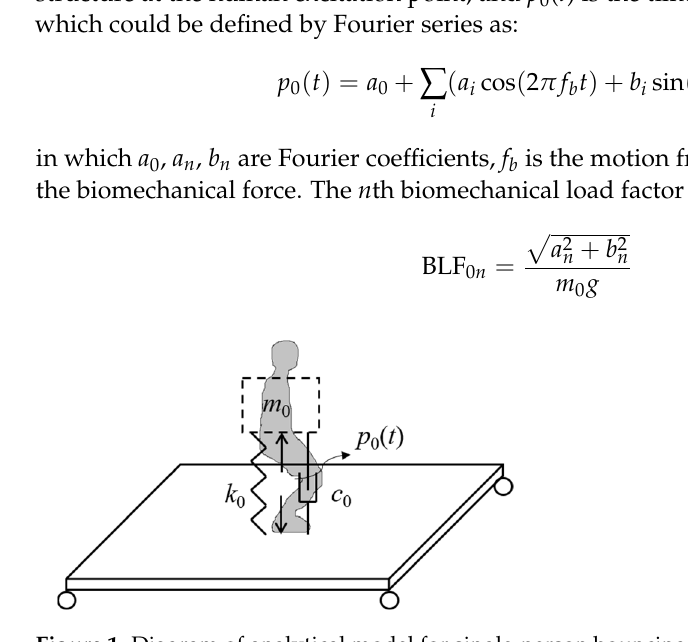
Figure 1. Diagram of analytical model for single-person bouncing.